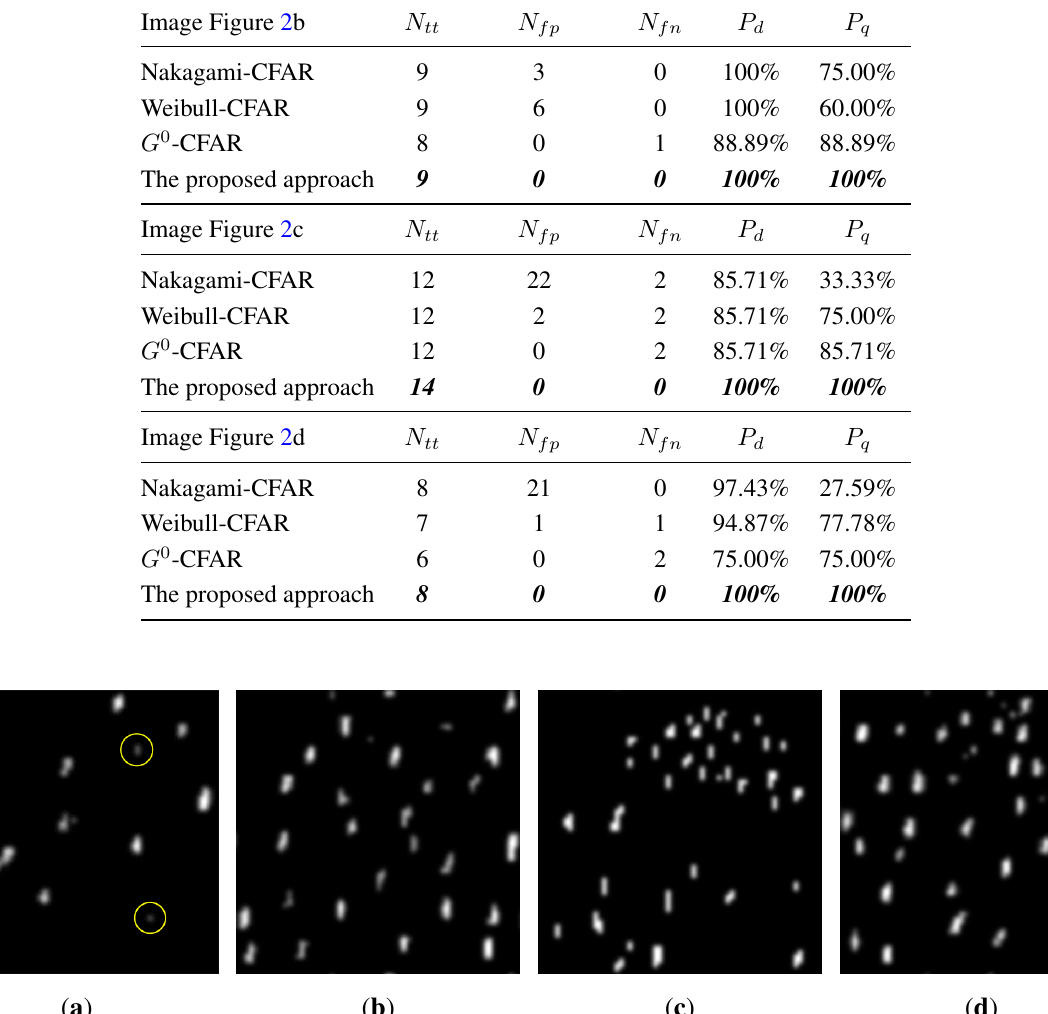
) of SAR images with complex scenes. ( a – d fn